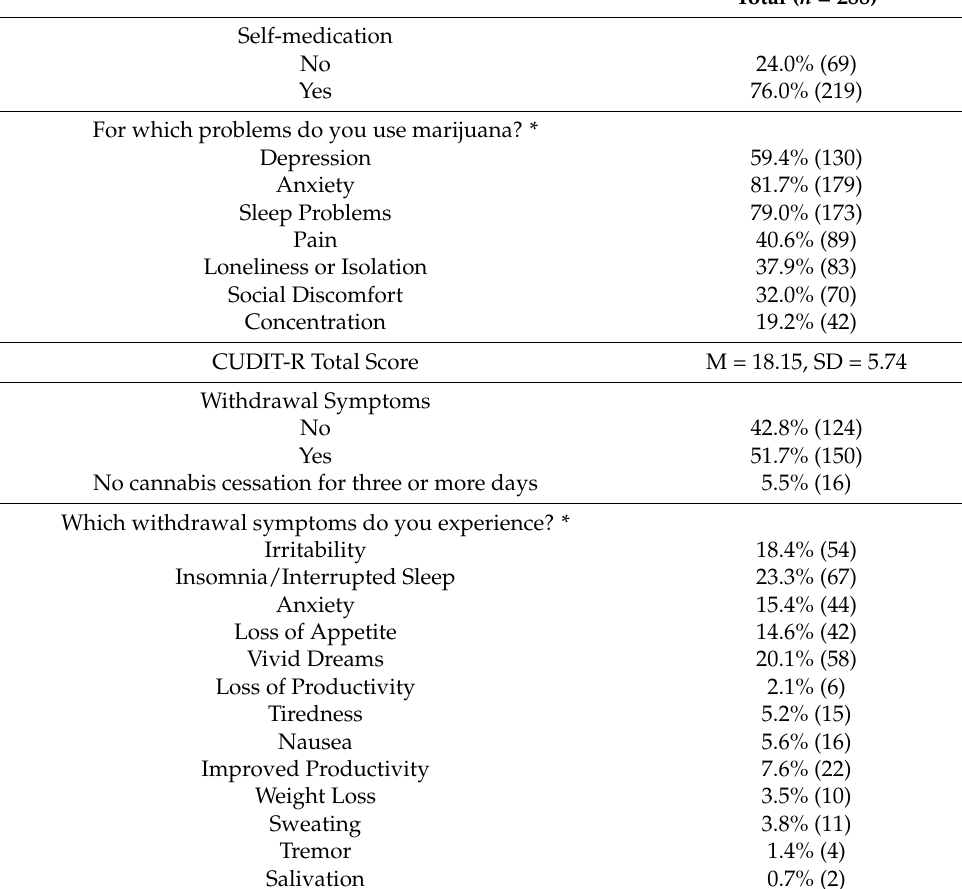
Table 1. Descriptive